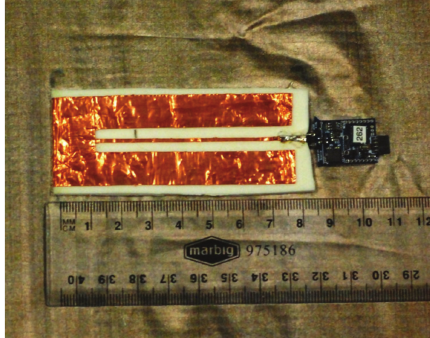
Figure 16: WISP connected to the proposed antenna. The silver fabric is attached using conductive